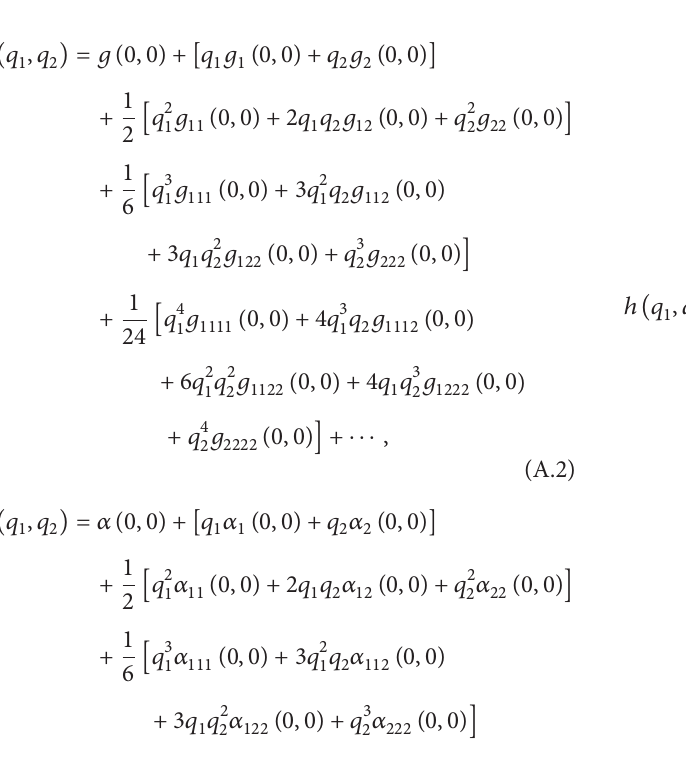
Figure 9: Combined graph for Figures 1, 2, and 3.